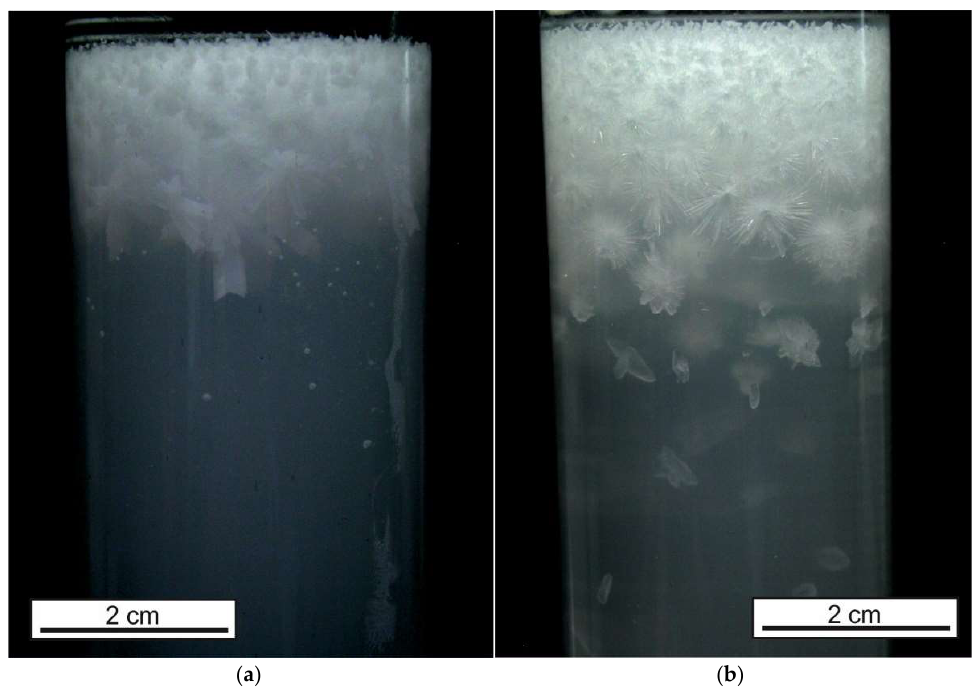
Figure 4. Gypsum crystals obtained using the single-diffusion setup with equal concentration (1 mol/L) of both reagents—CaCl 2 and Na 2 SO 4 : ( a ) Twinned crystals form in silica gel; ( b ) The use of 1% agar gel yields untwinned better crystals.